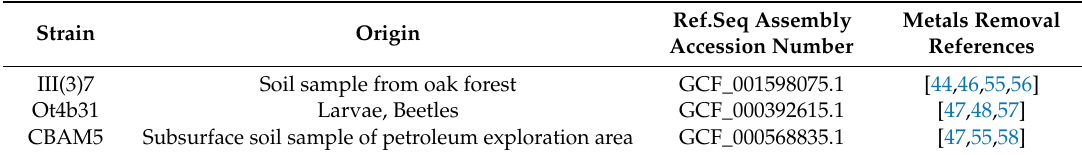
Table 1. Lysinibacillus sphaericus strains